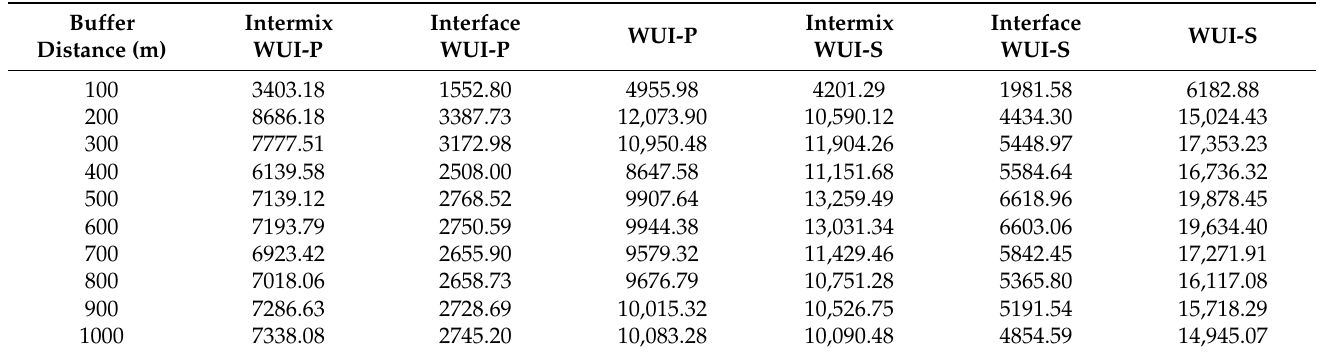
Table 2. The area of different types of WUI in WUI-P and WUI-S (unit: km 2 ).